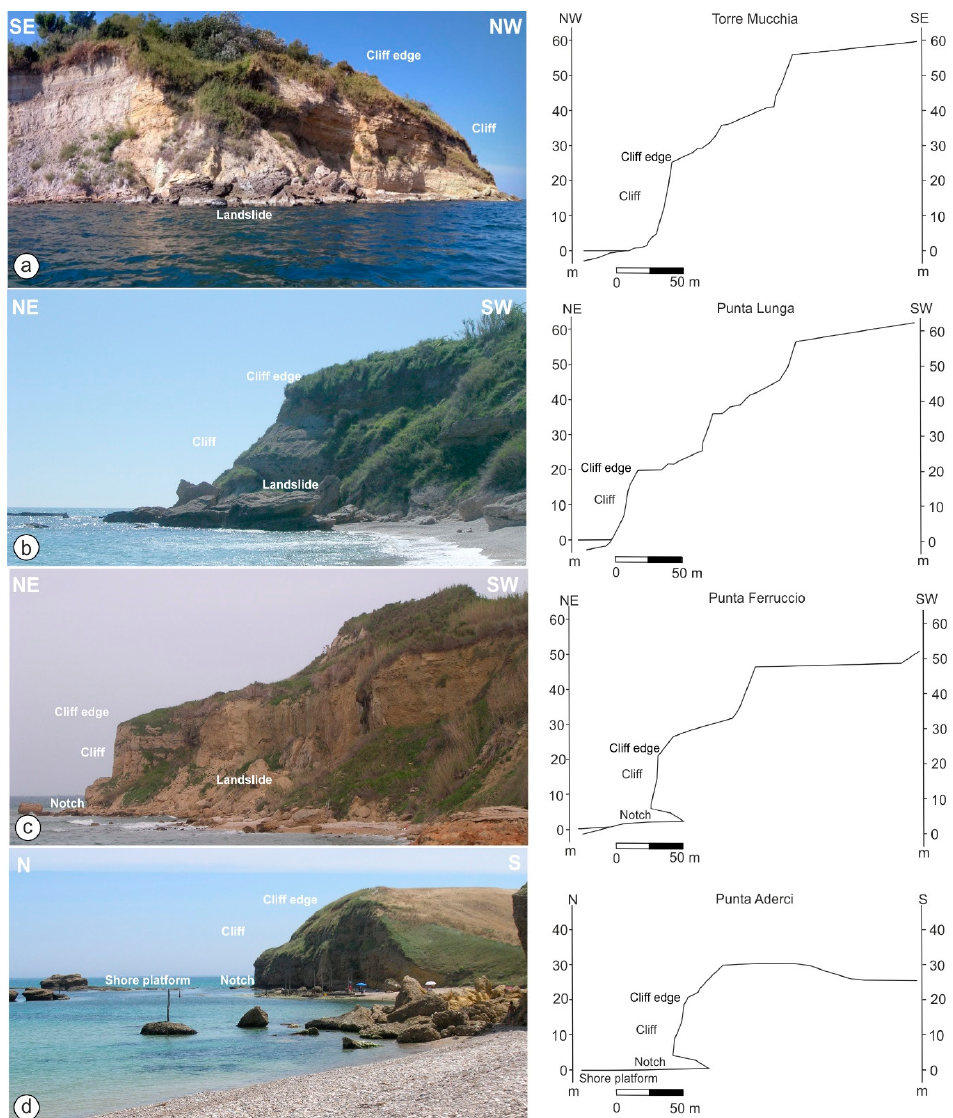
Figure 7. The landscape and topographic profile of: ( a ) Torre Mucchia; ( b ) Punta Lunga; ( c ) Punta Ferruccio; and ( d ) Punta Aderci.